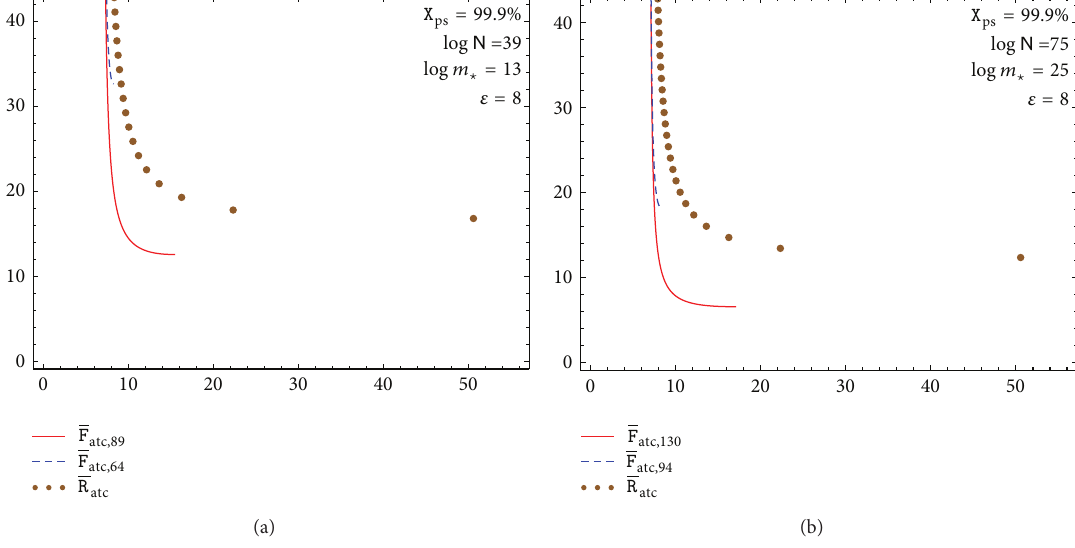
Figure 5: The adjusted tradeoff coefficients in relation to the precomputation coefficients for the perfect fuzzy rainbow, perfect rainbow, and nonperfect fuzzy rainbow tradeoffs at 99.9 % success rate (bottom: X